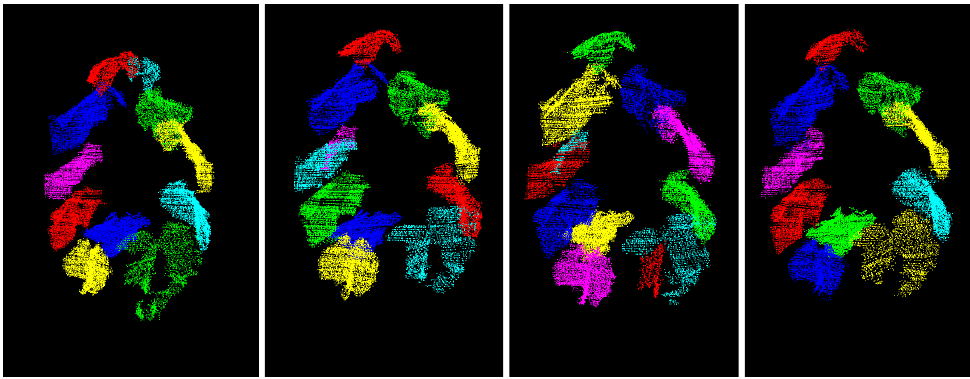
Figure 10. Result of the spatial segmentation of plant p 1_ e (the same colours in different point clouds do not have a meaning).